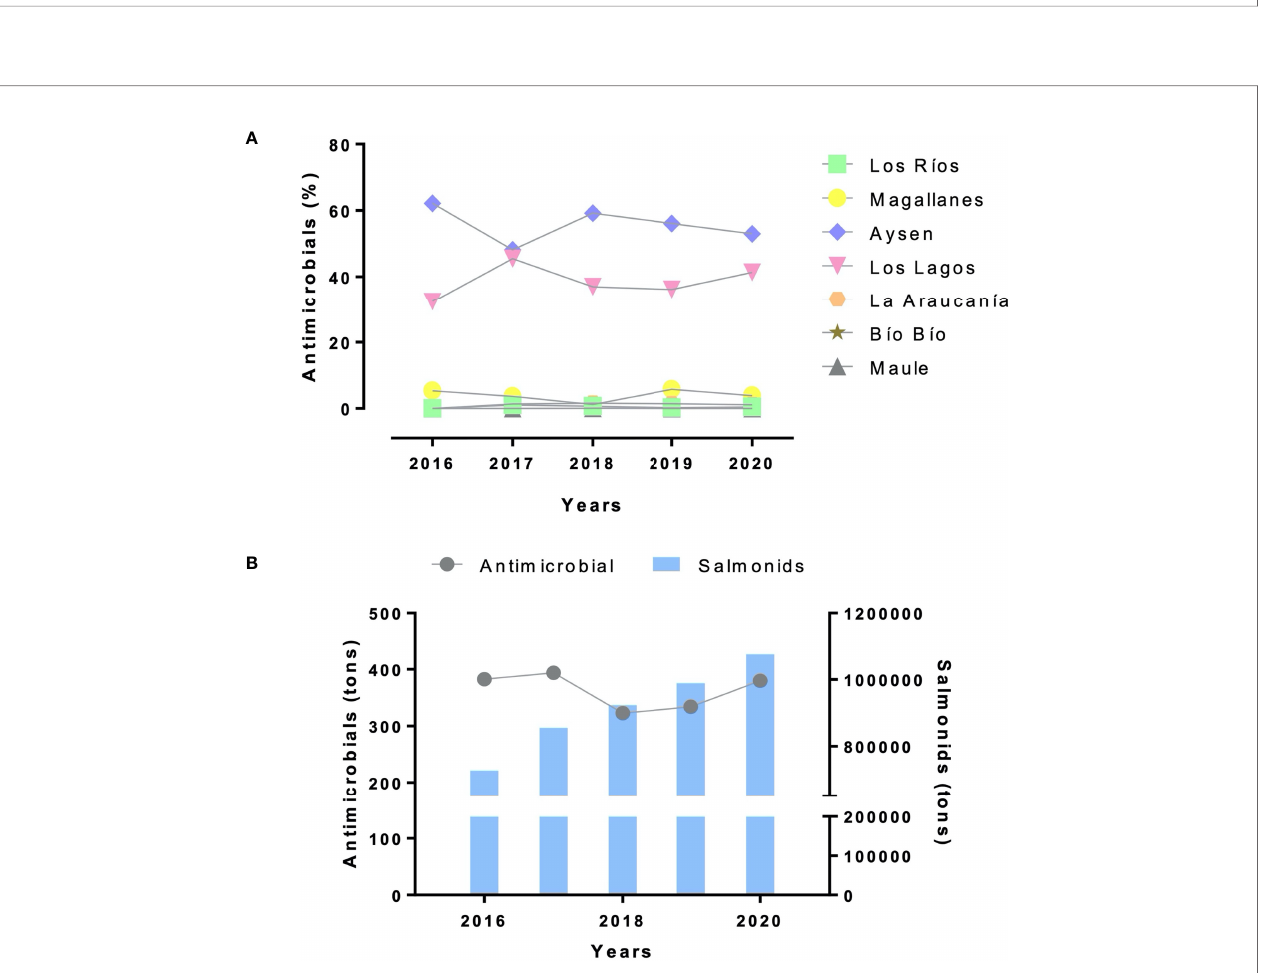
FIGURE 5 | Antimicrobial use in Chilean regions. (A) Percentage of antimicrobials (y-axis) used in major regions of aquaculture ’ s production and other regions during 2016-2020 (x-axis). (B) Comparison of antimicrobial use (in tons) and salmonid production (in tons) occurred in Los Lagos Region during the same period (2016- 2020,